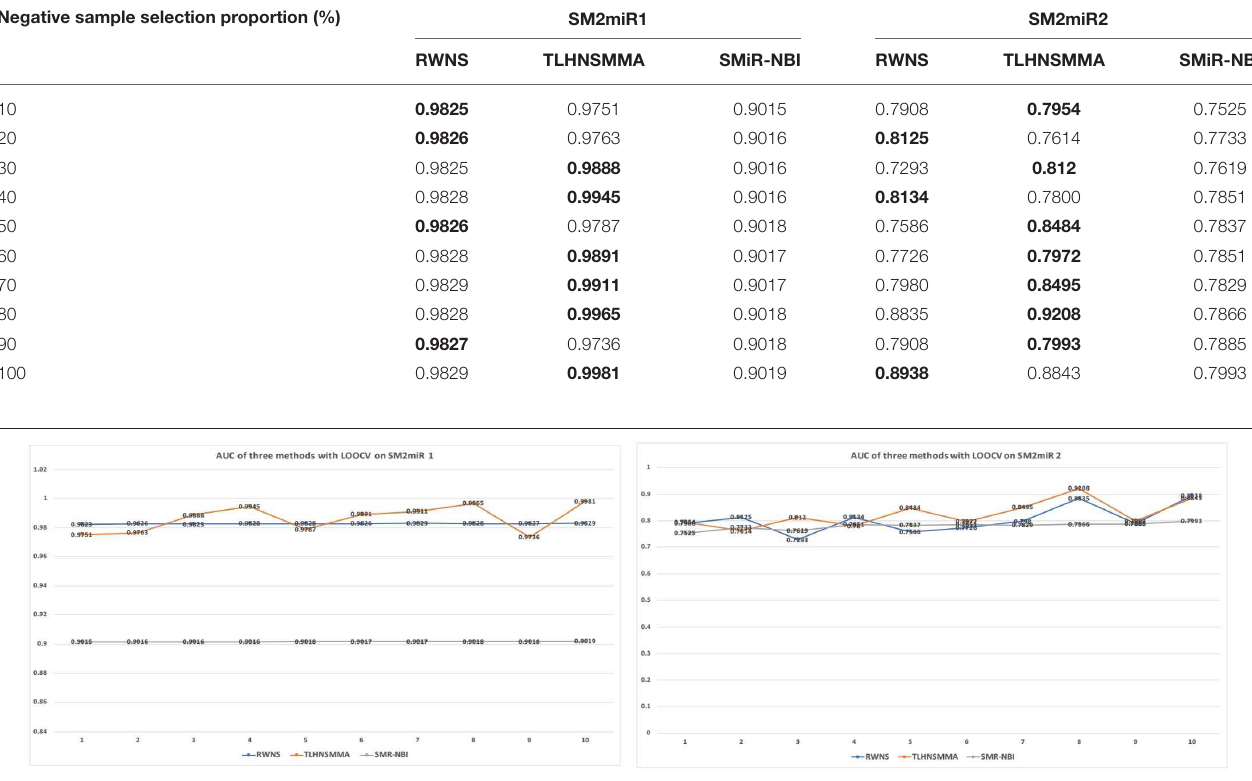
FIGURE 4 | The performance comparison of RWNS, TLHNSMMA, and SMiR-NBI under LOOCV on SM2miR1 and SM2miR2.